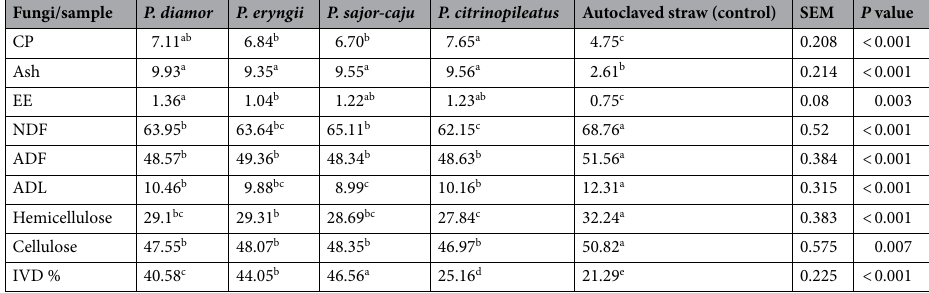
Table 1. Chemical composition of corn stover after 21 days of incubation with various white rot fungi ( Pleurotus sp.) or control. SEM: standard error of mean. a–e Within a row, means without a common superscript differed ( P < 0.001).